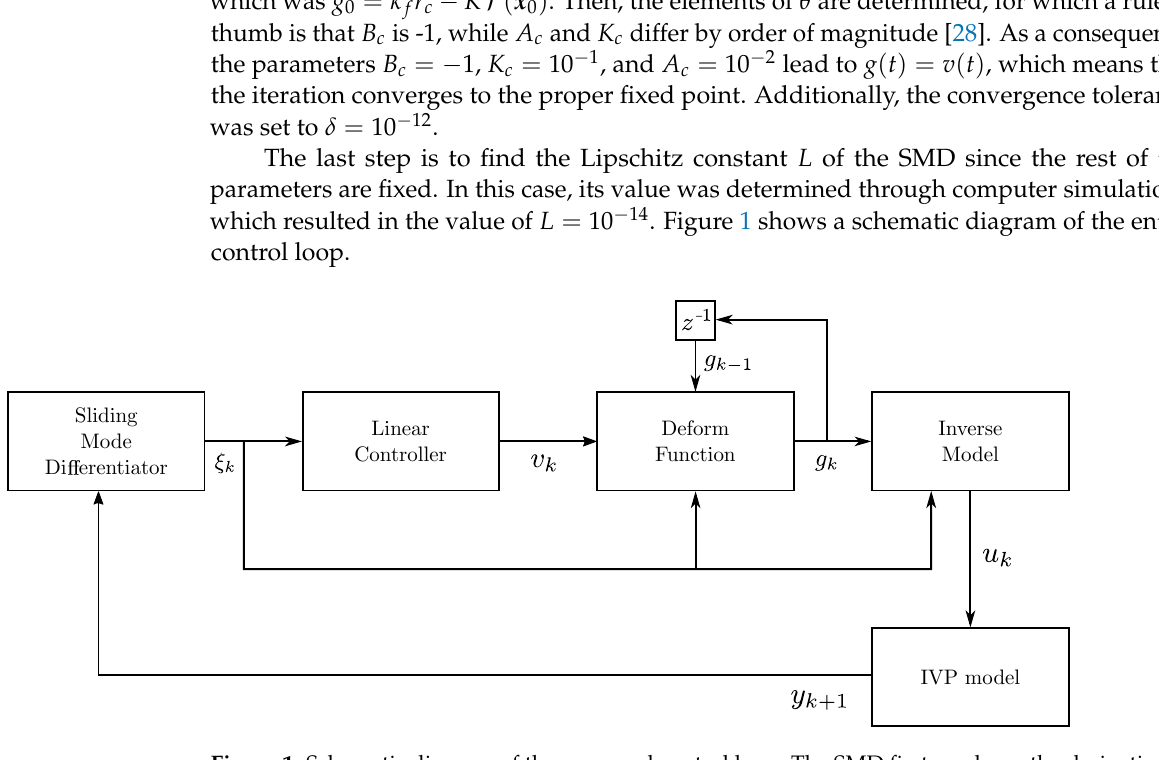
Figure 1. Schematic diagram of the proposed control loop. The SMD first produces the derivatives ξ of y = x 4 . Then, the linear controller calculates v = k f r c + K ξ , which is used in the deform function to create the error ˙ ξ 4 − v and perform one step of the RFPT iteration. The resulting iterate is then used to calculate the input signal for the system via the inverse model, and the cycle repeats at each